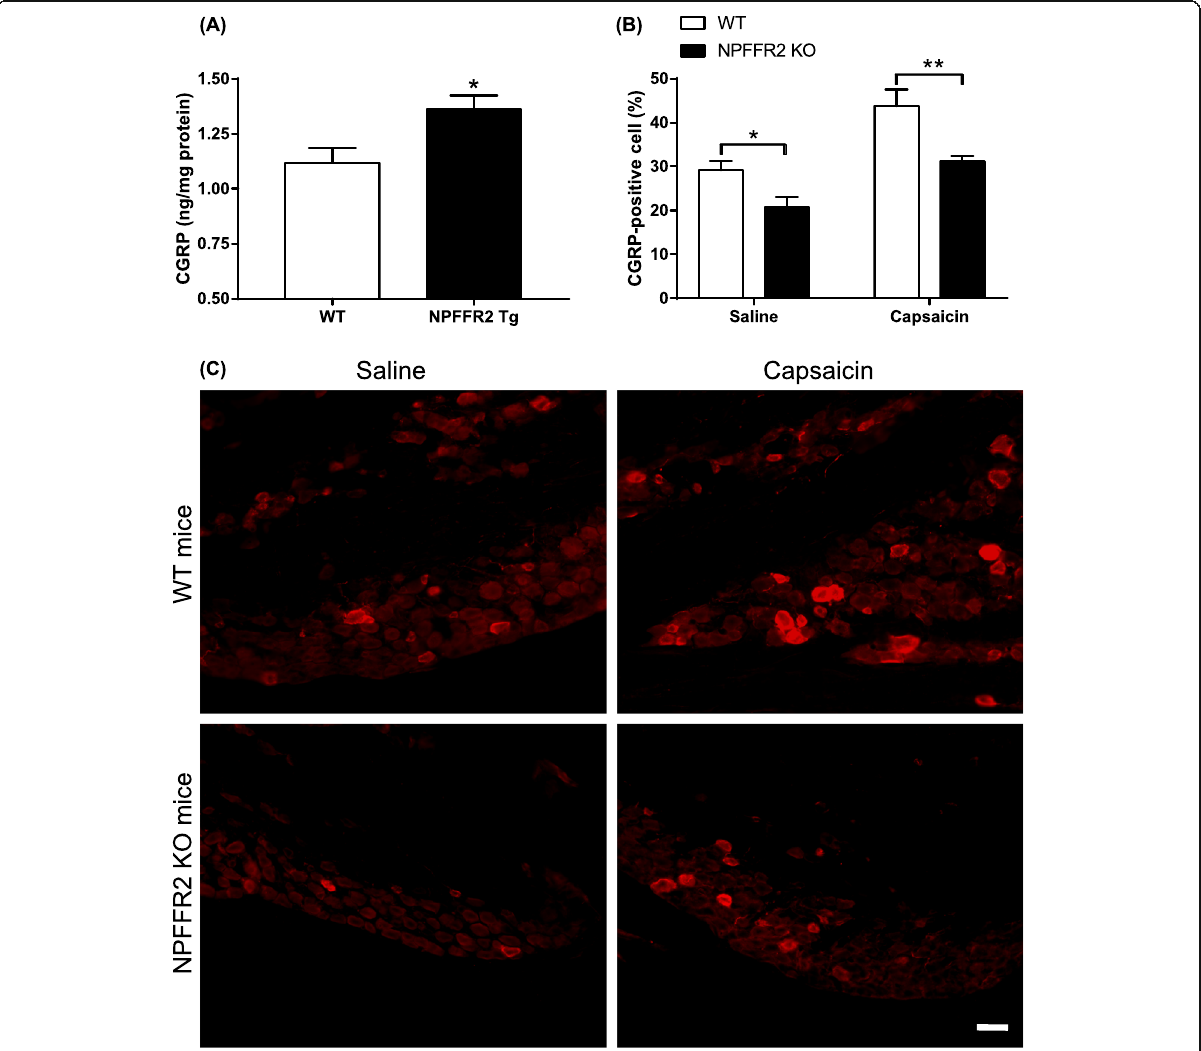
Fig. 4 The trigeminal CGRP of NPFFR2 overexpressed Tg mice and the capsaicin-upregulated CGRP expression in NPFFR2 KO mice. a The level of CGRP in trigeminal ganglion of NPFFR2 Tg mice was measured by ELISA. Data are represented as the mean ± SEM and were analyzed by unpaired Student ’ s t -test. * p < 0.05 compared to the control ( N = 9 per group). b WT and NPFFR2 knockout (KO) mice were intracisternally infused with capsaicin for 2 h, after which trigeminal ganglion was collected. CGRP protein level in the trigeminal ganglion was measured by immunofluorescence staining. The results are presented as percentage of CGRP-positive cell number. Data are represented as mean ± SEM and were analyzed by two-way ANOVA with Bonferroni ’ s multiple comparisons test. * p < 0.05, ** p < 0.01, comparing WT and NPFFR2 KO mice (N = 5 in saline group, N = 4 in capsaicin group). c Immunofluorescence staining of CGRP in WT and NPFFR2 KO mice. Scale bar = 50 μ